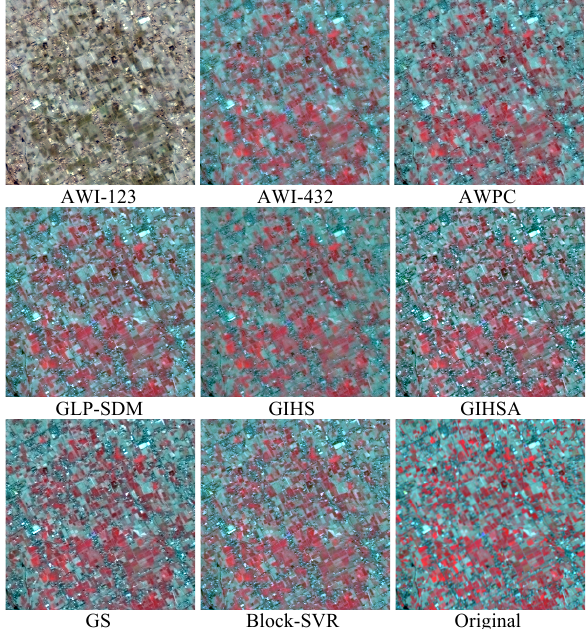
Figure 3. Pansharpened and original images in an agricultural